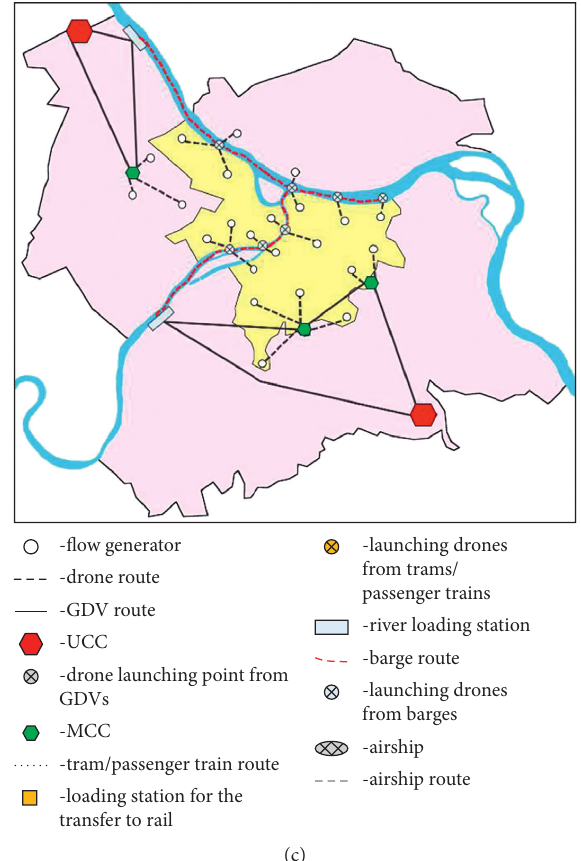
Figure 4: CL concept 4: hybrid delivery systems that combine mobile depots, MCCs, and drones. (a) GDV as mobile depots; (b) trams/ passenger trains as mobile depots; (c) barges as mobile